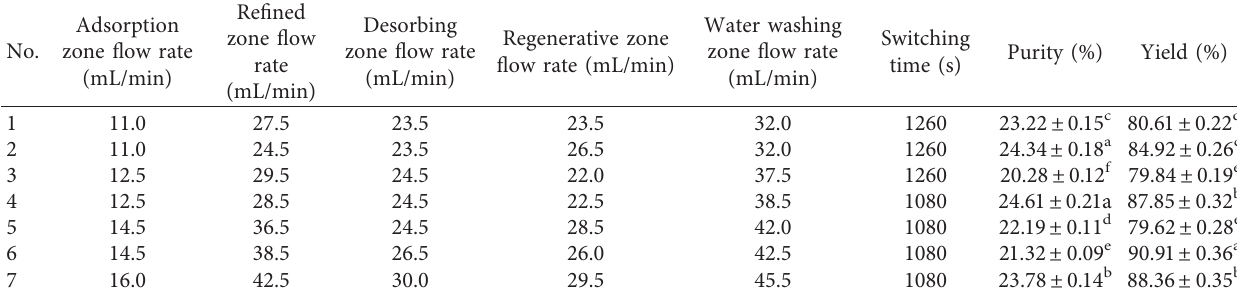
Table 2: SMB operating conditions and test results.